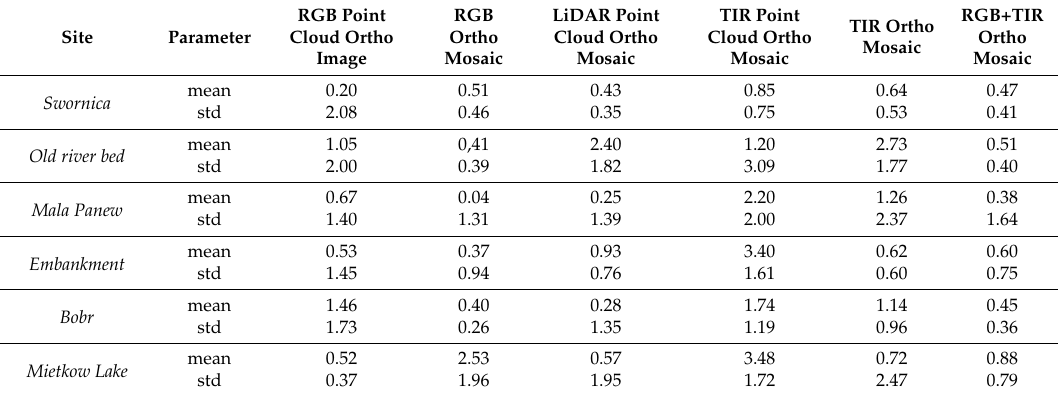
Table 6. The geometrical accuracy characteristics: All values are in (m). “mean” stands for the mean value and “std” stands for the standard